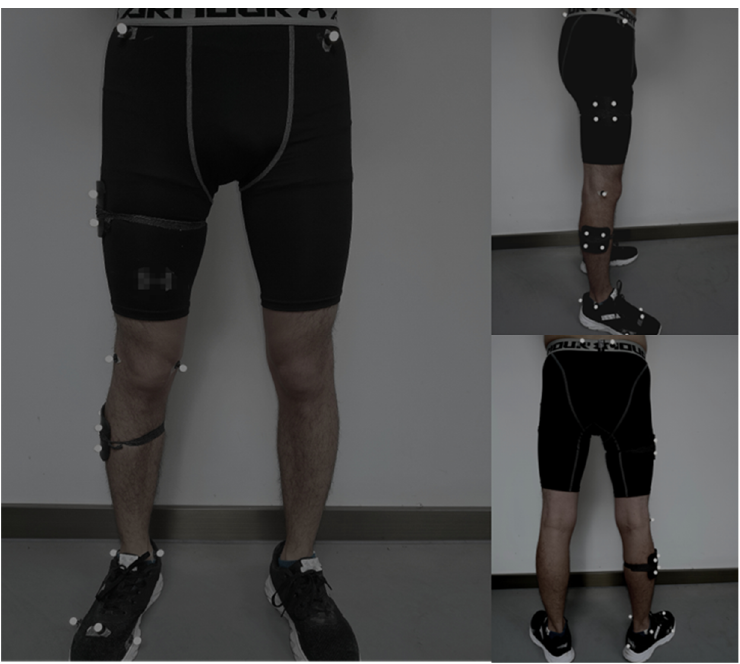
Figure 1. Illustration of the front, side, and back marker placements.